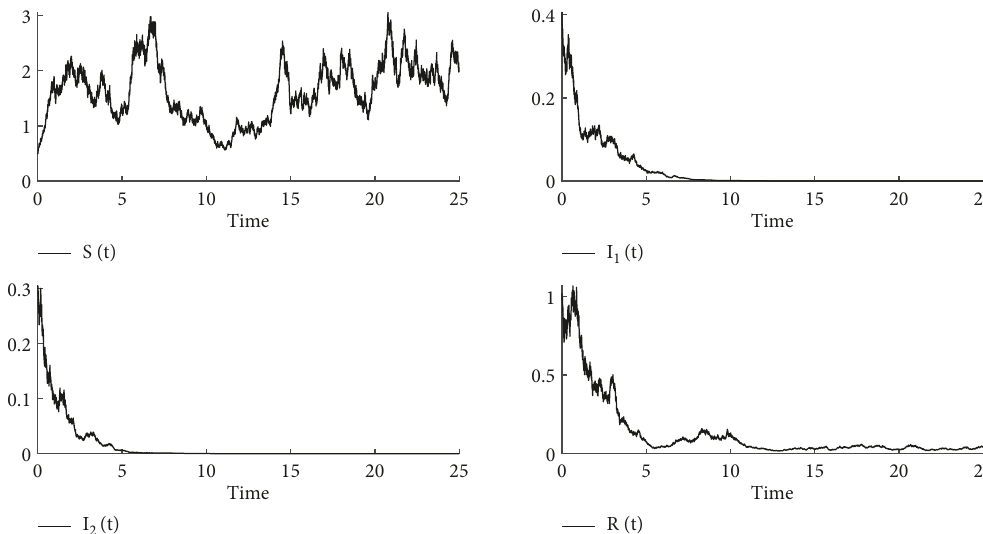
( t ) , I ( t ) , and R ( t ) for the stochastic systems 1 2